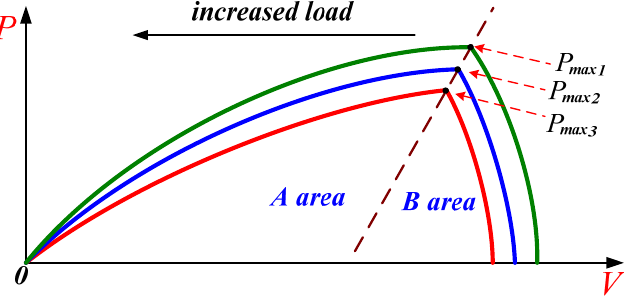
Figure 8. Output power and output voltage curves of PV arrays with different